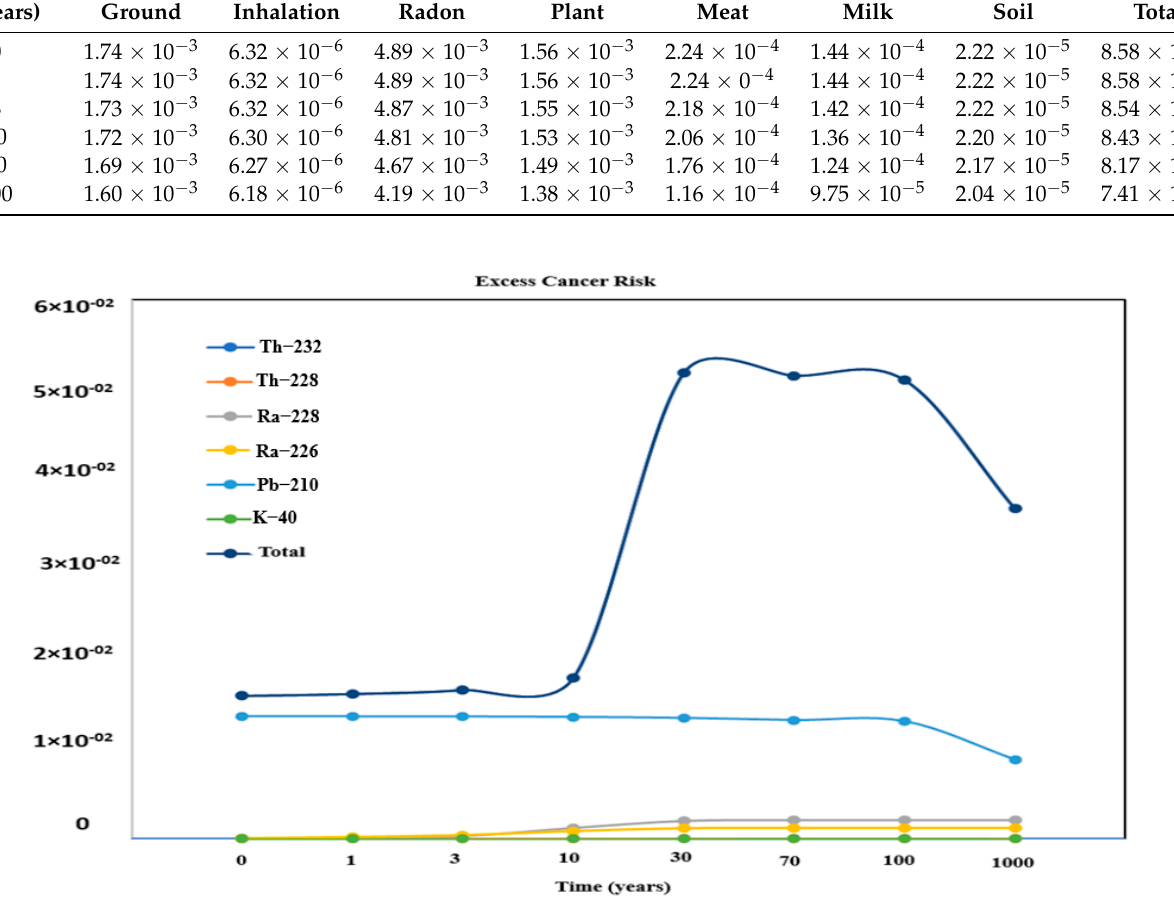
Figure 7. Long-term total excess risk for each nuclide. Table 6. Total ECR for initially existent radionuclides and pathways and fraction of total risk.